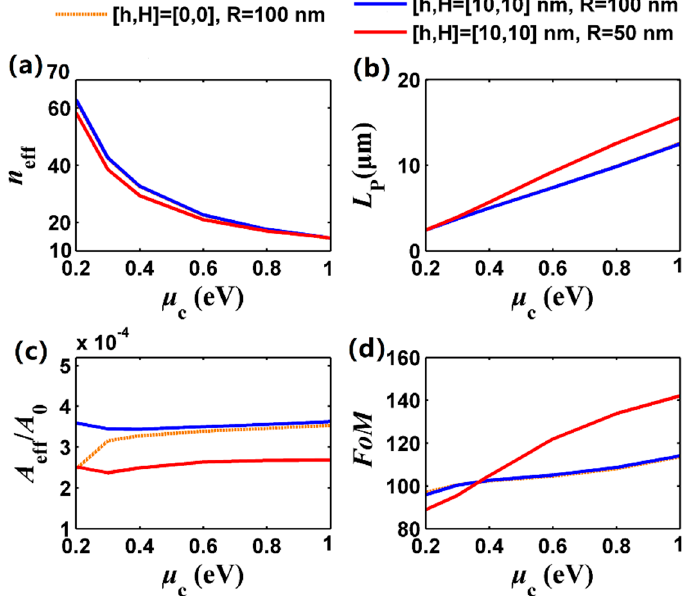
Figure 6. Dependence of the FGPM properties on chemical potential. ( a ) Effective mode index; ( b ) propagation length; ( c ) normalized mode size; and ( d ) FoM. The dotted brown curve for [ h , H,R ] = [0,0,100] nm, solid blue curve for [ h , H,R ] = [10,10,100] nm, and solid red curve for [ h , H,R ] = [10,10,50] nm. f 0 is 30 THz and μ c ranges from 0.2 eV to 1 eV. Other parameters are the same as Figure 2.